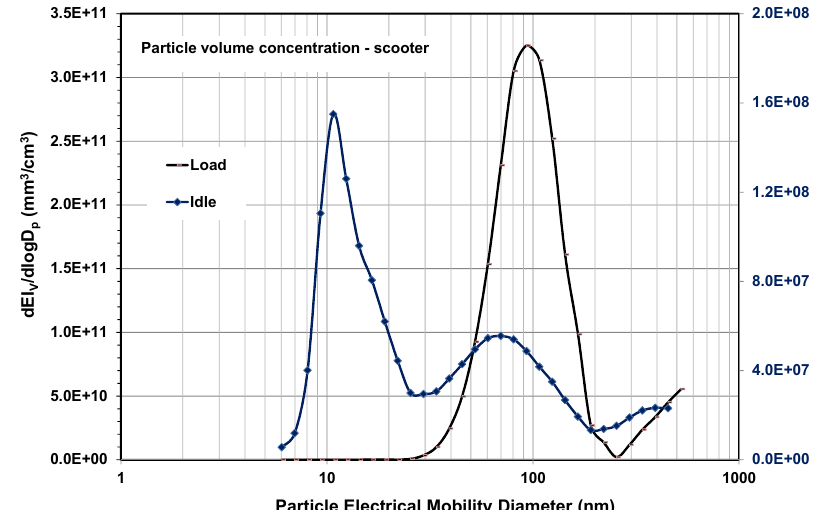
Figure 6. Particle volume distribution obtained for scooter.